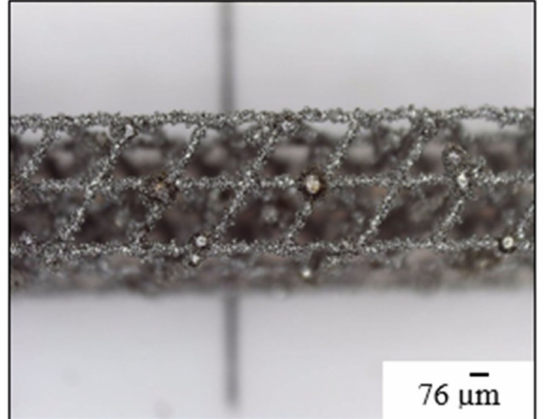
Figure 5. Microscope image of octahedron structure with metal